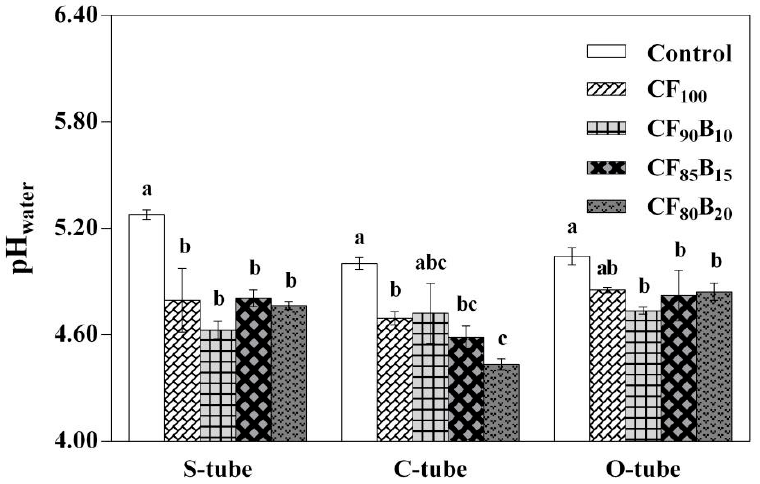
Figure 2. Coupled effect of reduced chemical fertilization and palm silk biochar (PSB) supplemen- tation on pH water in 0–40 cm soil layer. Abbreviations: S-tube, starting tube; C-tube, top-covered tube; O-tube, top-open tube. Treatments: Control, no fertilization; CF 100 , 100% conventional fer- tilization; CF 90 B 10 , 90% conventional fertilization plus 10% PSB-based fertilization; CF 85 B 15 , 85% conventional fertilization plus 15% PSB-based fertilization; CF 80 B 20 , 80% conventional fertilization plus 20% PSB-based fertilization. Data are expressed as means ± SD ( n = 3). For each tube type, bars labeled with different lowercase letters (e.g., a, b, c, etc.) indicate significant ( p < 0.05) differences among the treatments based on the Tukey test or Games-Howell